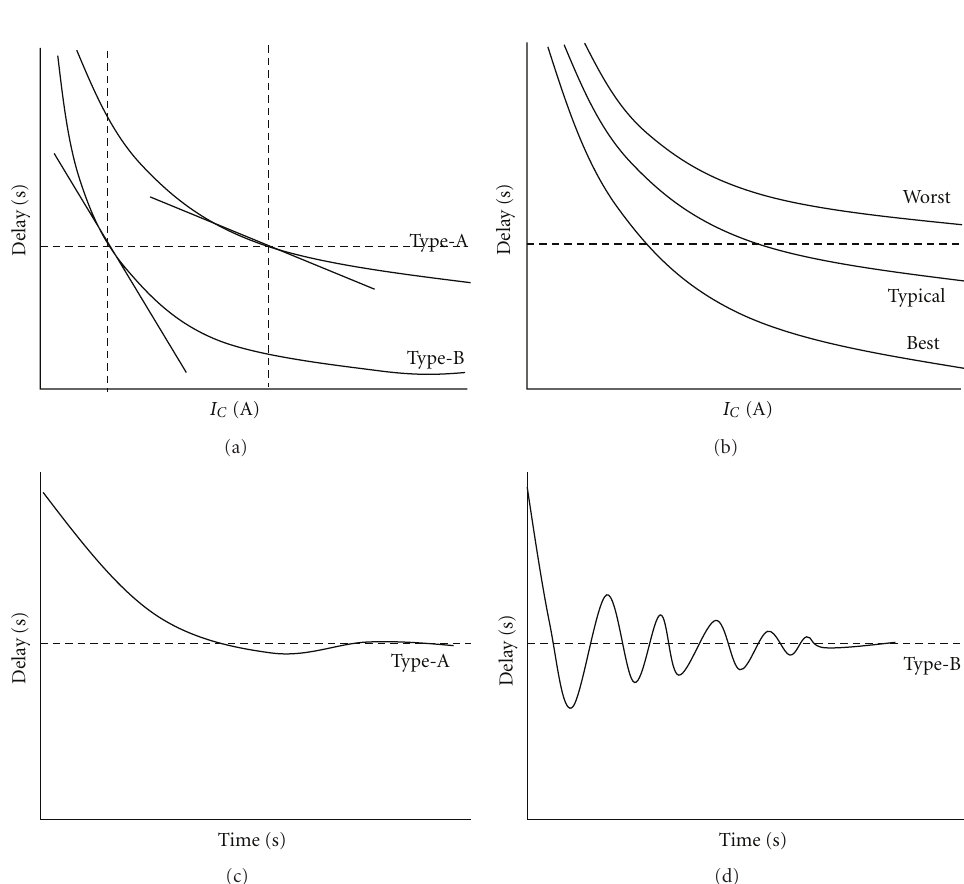
Figure 15: Explanation of the VCDL and DLL operation. (a) The explanation of the VCDL delay-current characteristics. The type-A VCDL has the smooth sensitivity and the type-B has the steep sensitivity. (b) The explanation of the influence of the VCDL delay-current characteristics due to the PVT variation. (c) The explanation of the DLL settling operation by using type-A VCDL. The settling operation is smooth because the sensitivity of the VCDL is not steep. (d) The explanation of the DLL settling operation by using type-B VCDL. The settling operation is not smooth because the sensitivity of the VCDL is